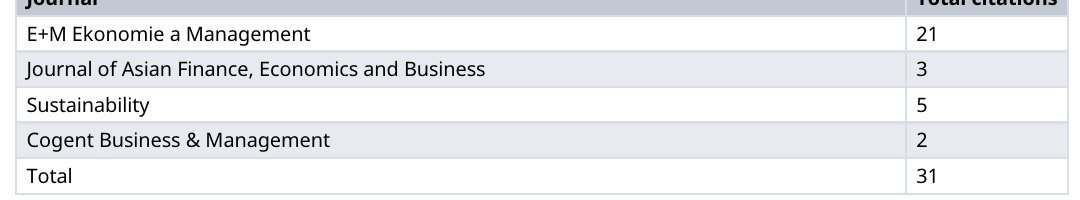
Table 4. Citations per